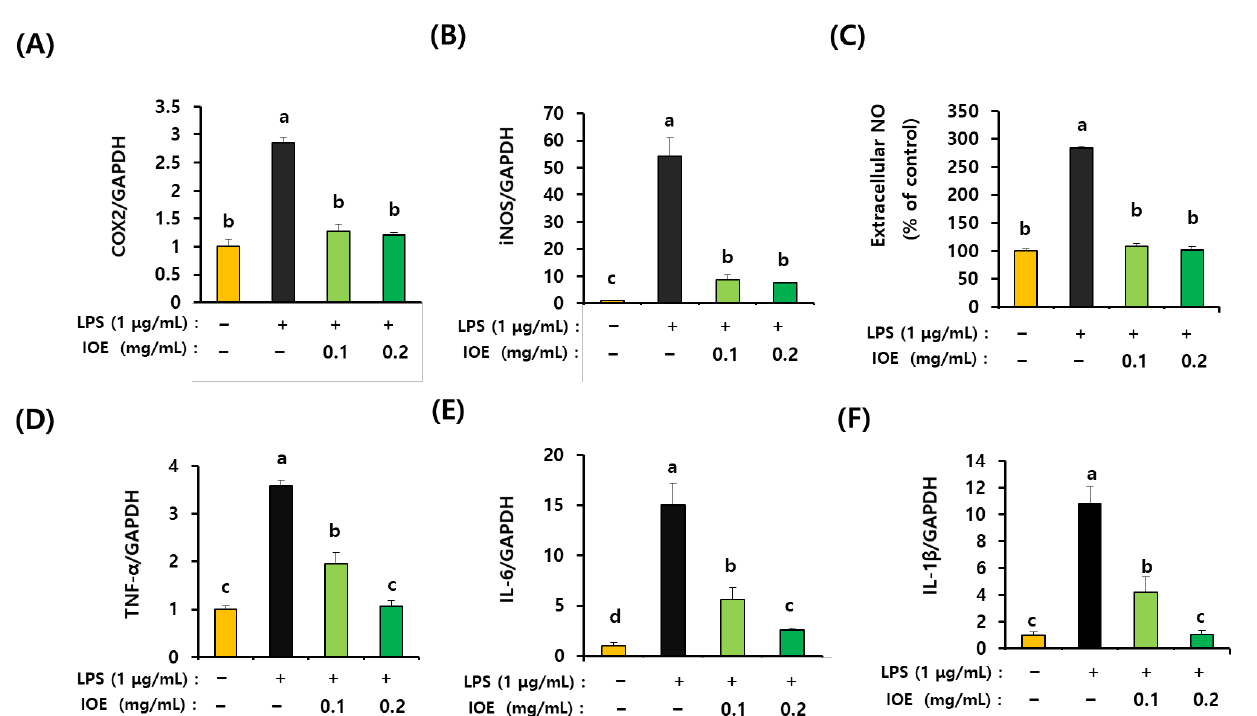
Figure 9. IOE ameliorated the inflammatory mediators in C6 glioma cells treated with LPS. C6 glioma cells was pretreated with non-toxicological levels of IOE (0.1 and 0.2 mg/mL) and then LPS (1 ug/mL) was treated to C6 glioma cells for 15 h. The expression of COX-2 ( A ), iNOS ( B ), TNF- α ( D ), IL-6 ( E ), and IL-1 β ( F ) was estimated qRT-PCR and the amount of extracellular NO ( C ) in cell media was evaluated by using a microplate reader. These experiments were repeated three times with similar results. Data shown are the mean ± SD and different letters (a–d) indicate the significant differences among treatments ( p < 0.05). Each value is assigned as a, b, c and d sequentially from the highest value.